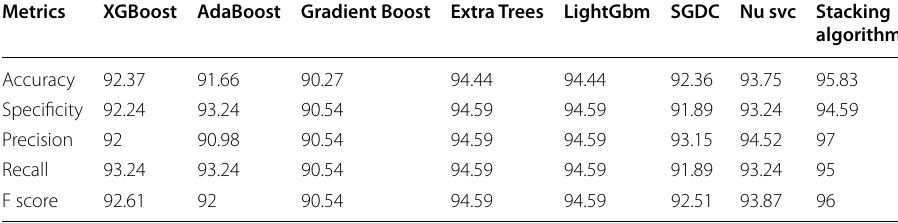
Table 4 Machine learning algorithms results UCI heart disease Metrics